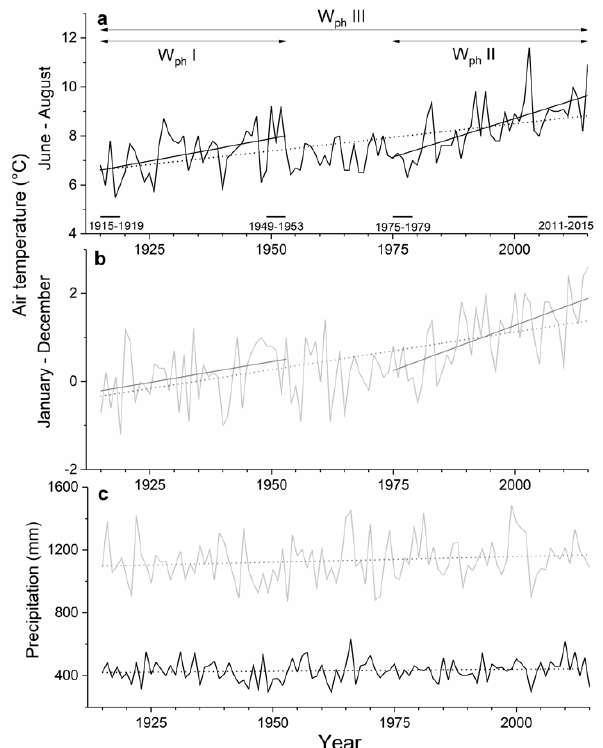
Figure 1. Mean air temperature ( a , b ) and precipitation ( c ) during June–August (black lines) and January–December (grey lines) in the Alpine region for the period 1915–2015. In (a), increase in air temperature was divided into two phases: phase I (W ph I) from 1915–1953 and phase II (W ph II) from 1975–2015. Period III (W ph III) encompasses the whole study period 1915–2015. Linear air temperature and precipitation trends are shown in solid lines for W ph I and W ph II and dotted lines for W ph III. Five-year periods used to calculate mean values of air temperature and basal area increment during selected periods (W ph I ‐ III) are indicated.